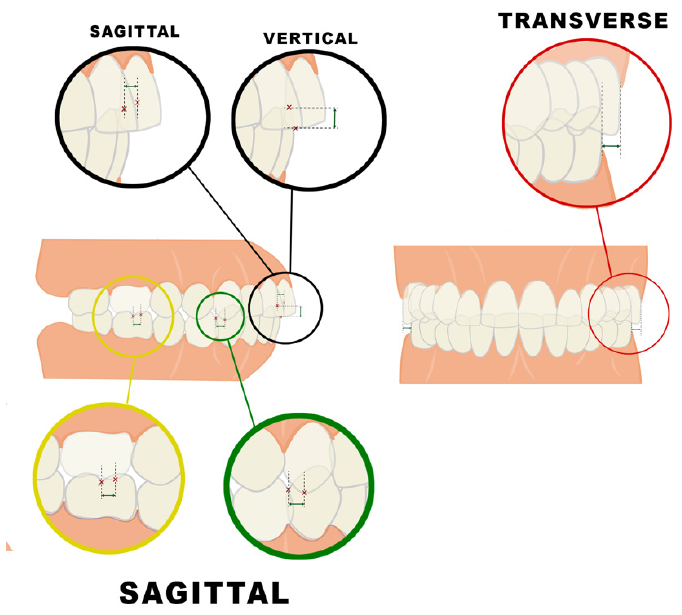
Figure 2. Intraoral occlusal measurements. Table 1. Intraoral occlusal measurements in the three spatial planes; sagittal, vertical and transverse.